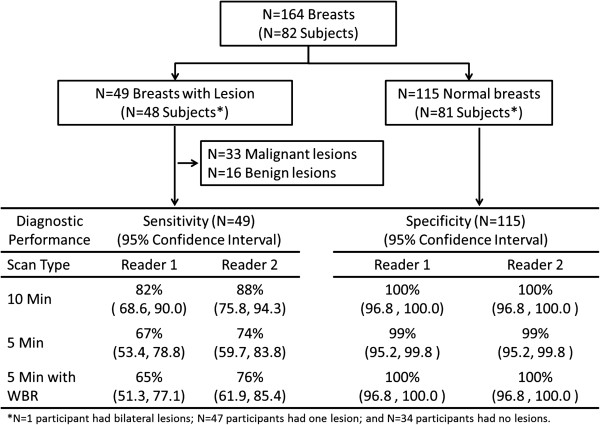
Number of subjects, breasts, and lesions included for sensitivity and specificity analysis.